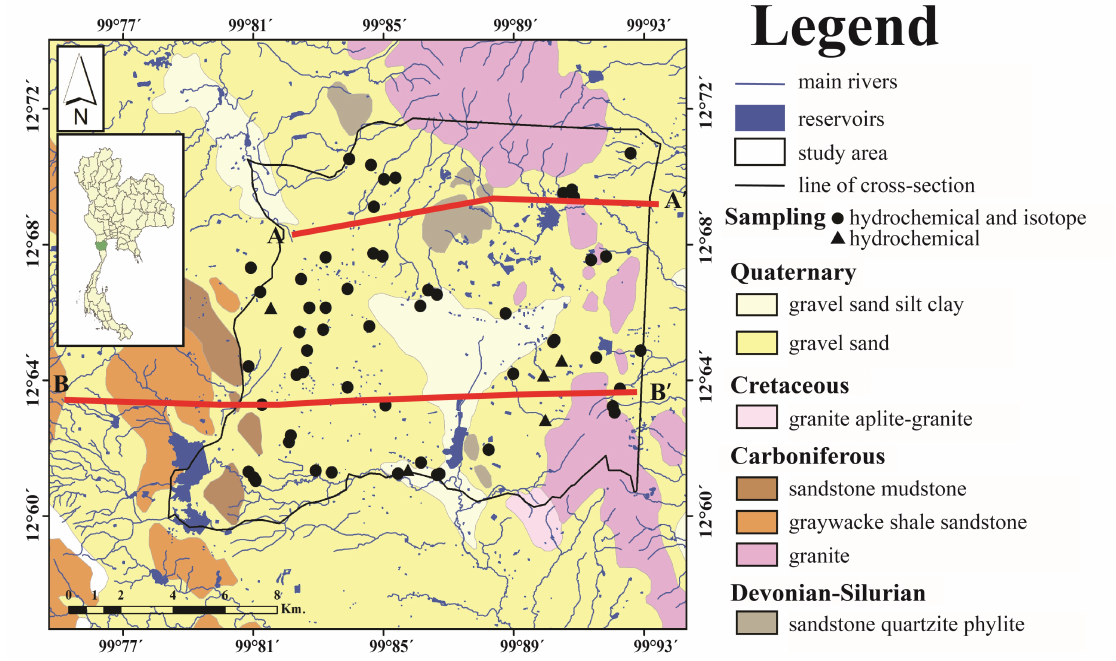
Figure 1. Geological map of the study